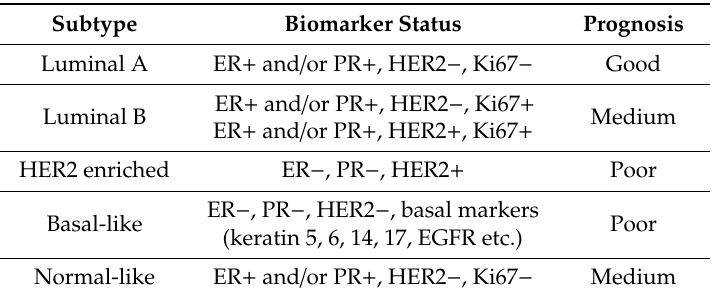
Table 1. Breast cancer (BC) molecular